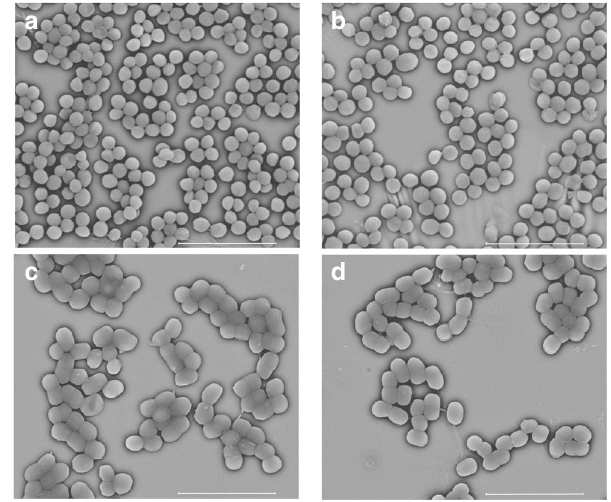
Fig. 6 SEM images for MRSA and A. baumannii with or without treatment of RD53 . a MRSA without treatment of RD53 . b MRSA after incubation with 8 × MIC (8 μ g mL − 1 ) RD53 for 4 h. c A. baumannii without treatment of RD53 . d A. baumannii after incubation with 8 × MIC (32 μ g mL − 1 ) RD53 for 4 h. SEM images were taken by FEI Nova NanoSEM 230. The SEM was operated in the high vacuum at an accelerating voltage of 7.5 kV. Scale bars represent 5 μ